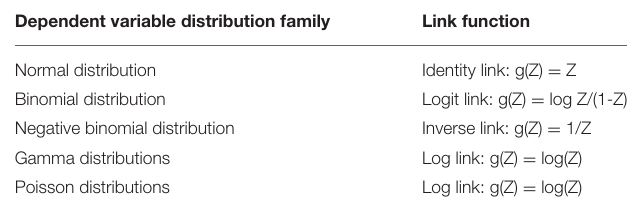
TABLE A1 | Distribution of response variable and link